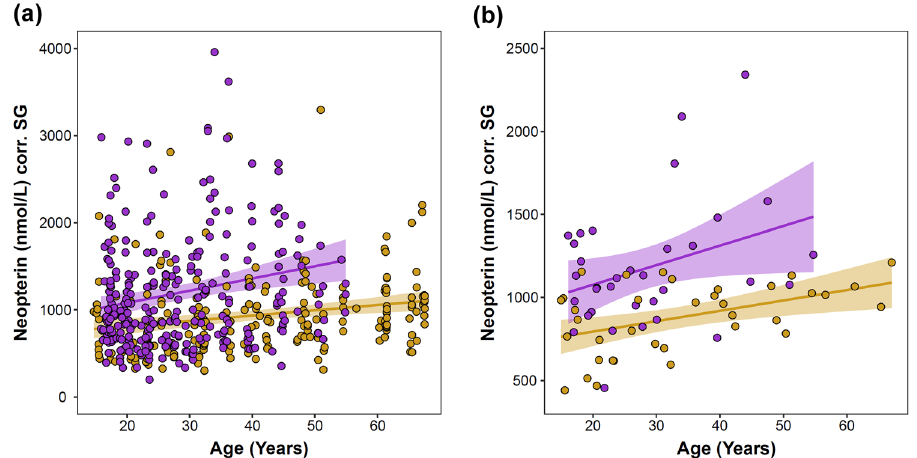
Figure 1. Urinary neopterin concentrations of wild chimpanzees by subject age and sex. Both the raw data points (a) and subject means (b) are presented. Shading around the regression lines indicates 95% confidence intervals. Yellow = females, purple = males. Two data points in Fig. 2a are greater than the maximum limit of the y-axis and are therefore not visible.